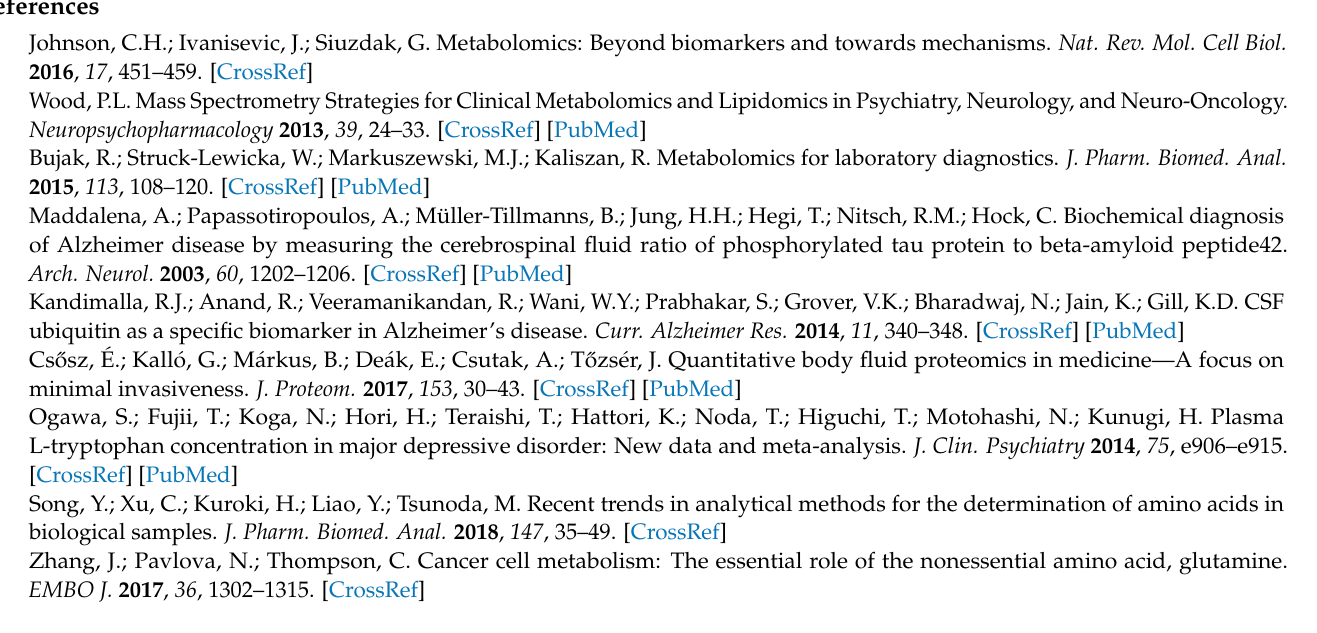
Table S5: Autosampler stability and freeze–thaw